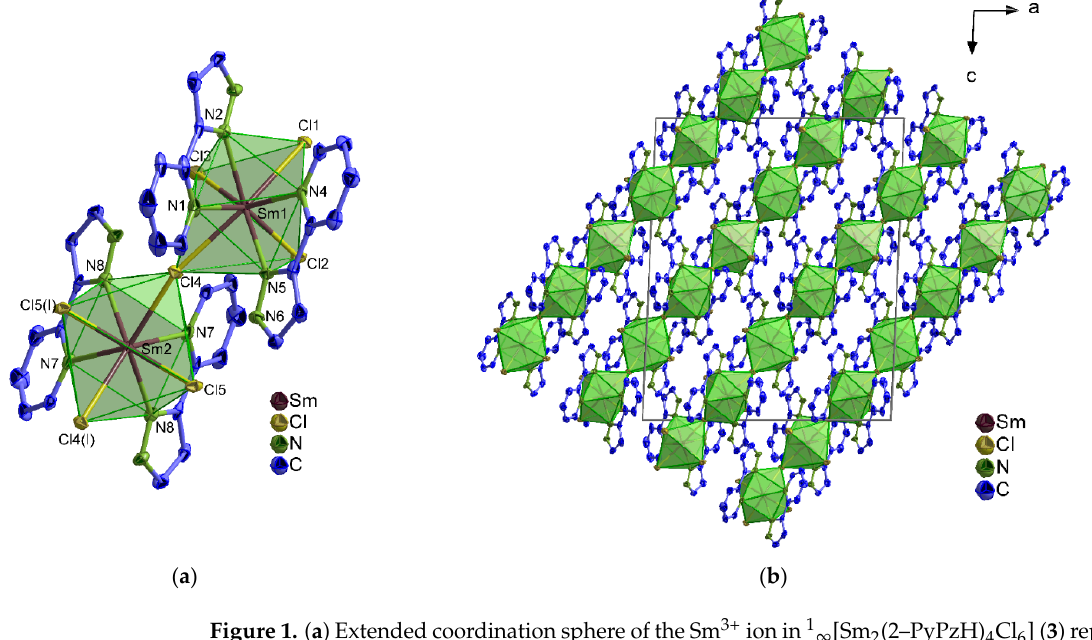
Figure 1. ( a ) Extended coordination sphere of the Sm 3+ ion in 1 ∞ [Sm 2 (2–PyPzH) 4 Cl 6 ] ( 3 ) representing the isotypic compounds 1 – 3 .; ( b ) crystal structure of 3 with a view along [010]. Symmetry operation: I − x+1,y, − z+1/2. In all figures, the hydrogen atoms are omitted for clarity and the coordination polyhedra around Ln 3+ are shown in green, with thermal ellipsoids shown with a probability of